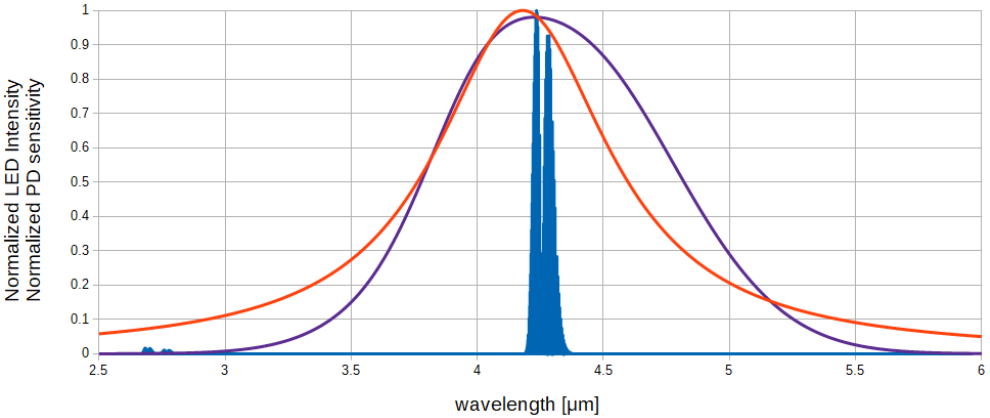
Figure 2. InAsSb/InAs LED (red) and PD (purple) spectra. CO 2 absorption band in the 4.2 µ m region (blue)